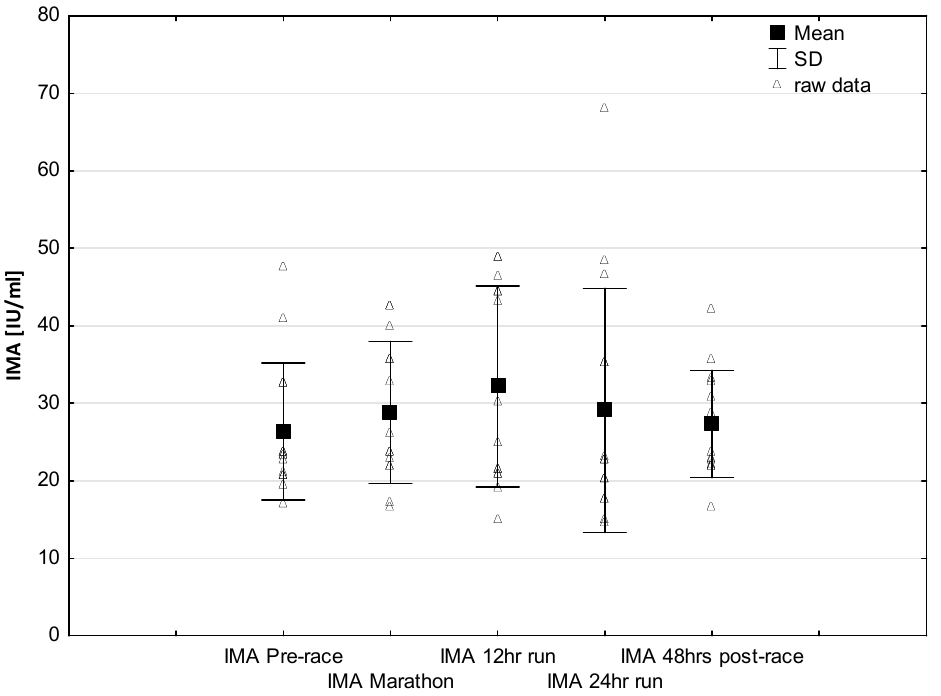
Figure 5. Ultra-marathon-induced changes in serum ischemia modified albumin (IMA).